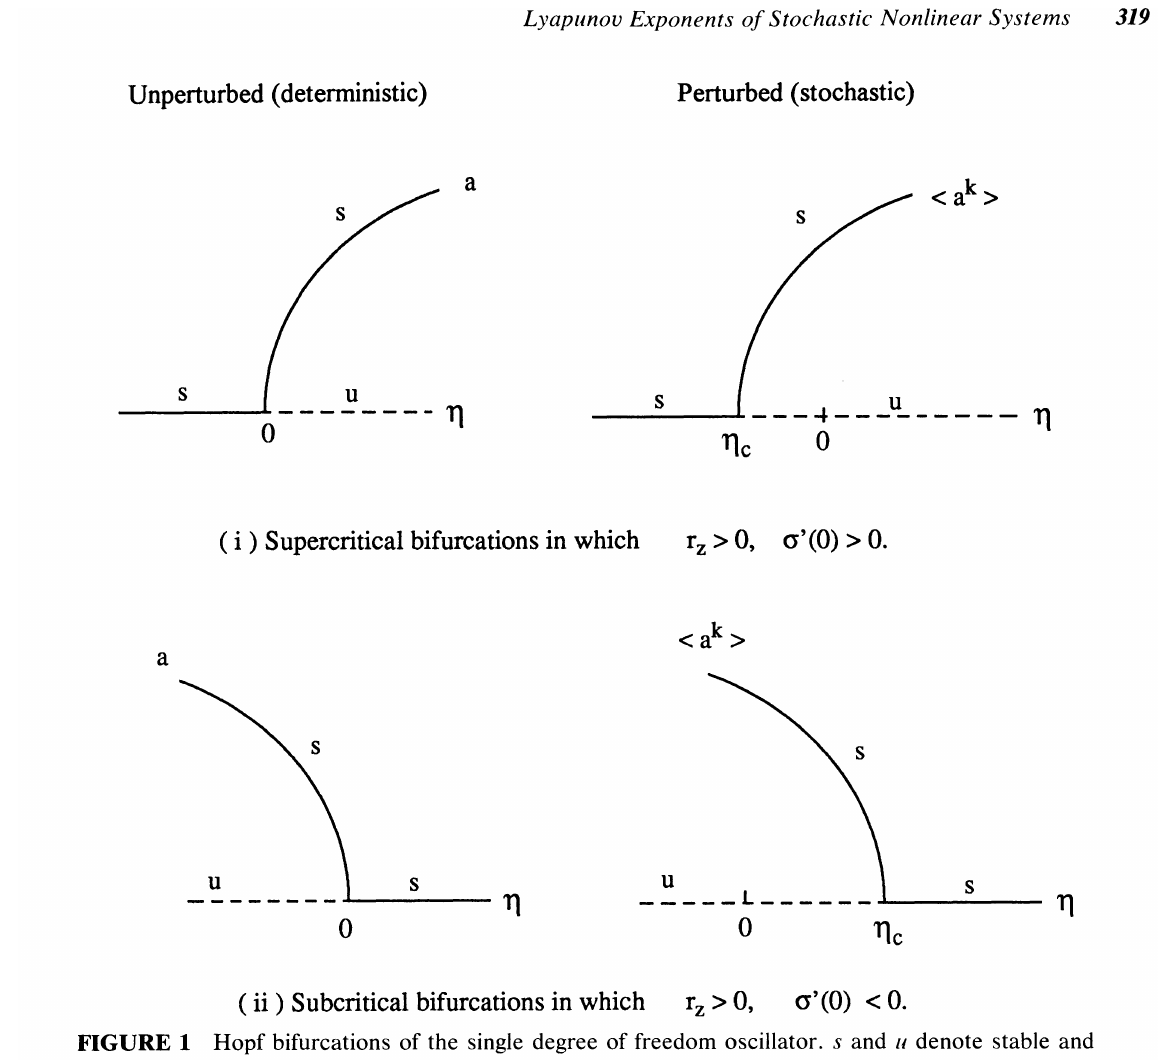
FIGURE 1 Hopf bifurcations of the single degree of freedom oscillator. s and II denote stable and unstable solutions,